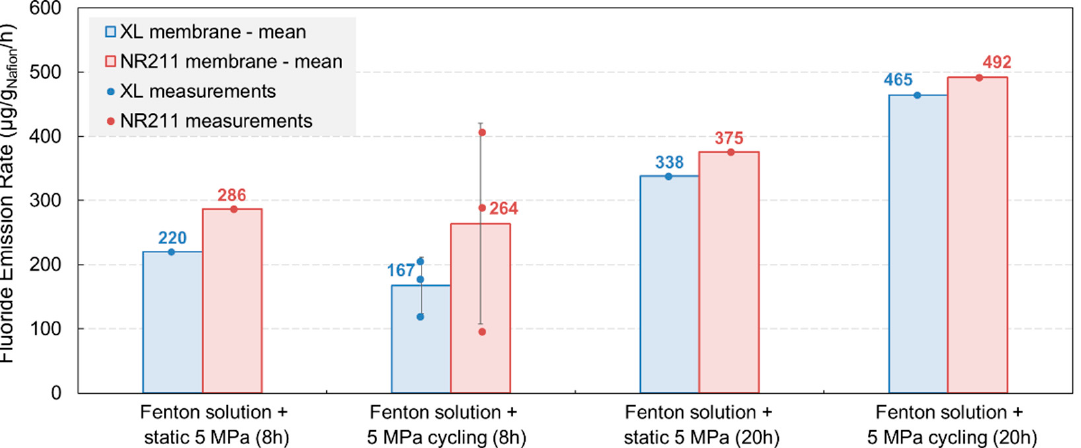
Figure 3. Comparison of the FER evolution after conjoint mechanical and chemical stress tests with static compression or cyclic compression for XL and NR211